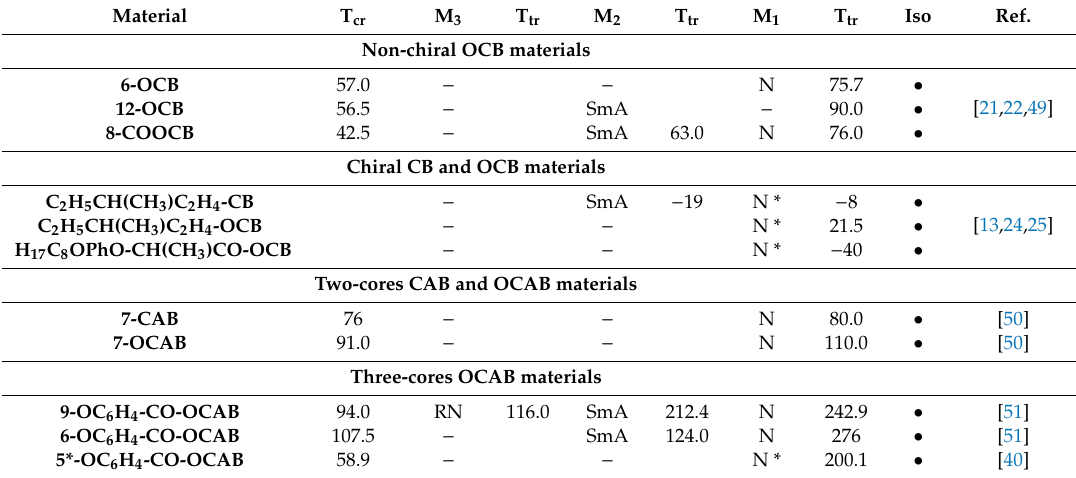
Table 2. Mesomorphic properties of the known